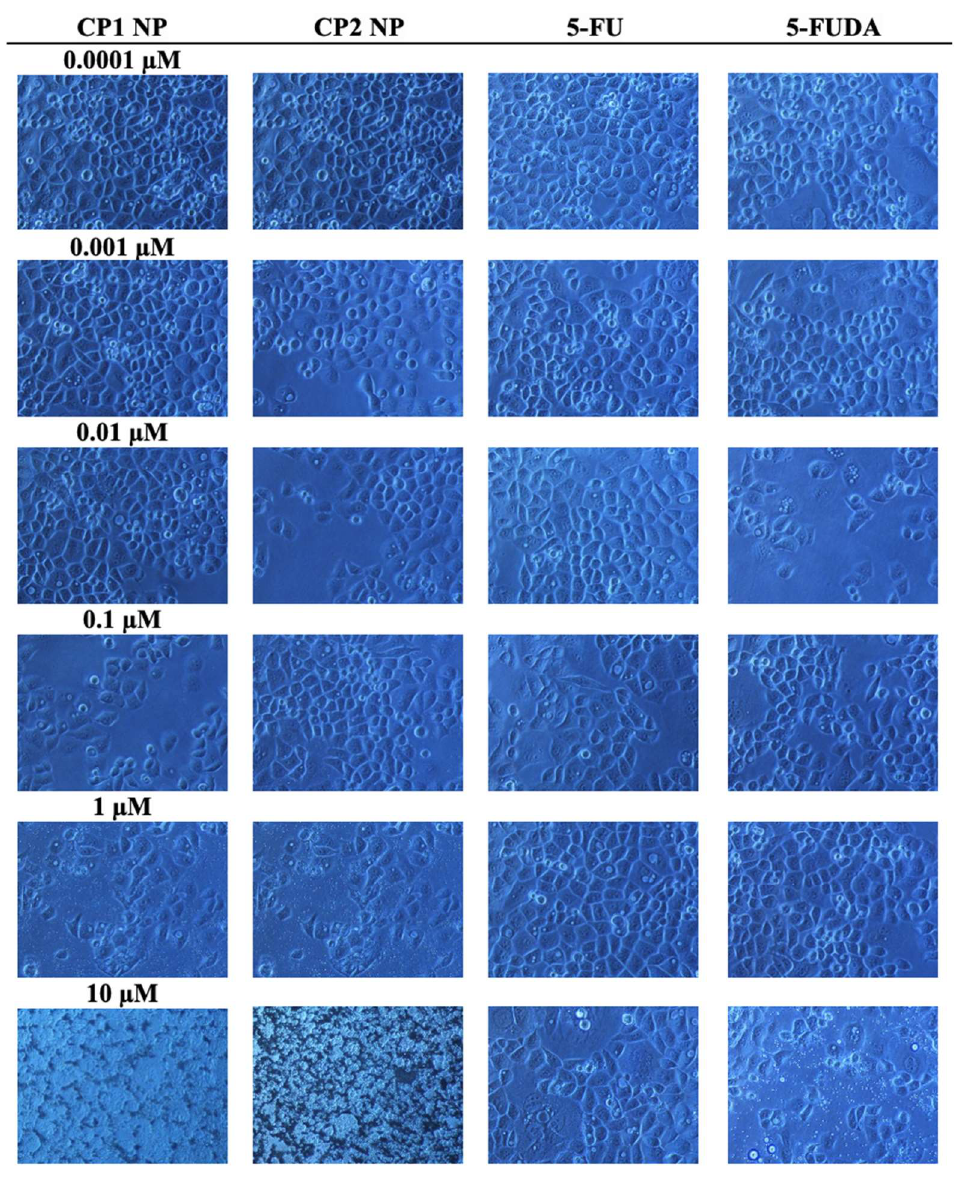
Figure 4. Microscopic images (magnification 20 × ) of PANC-1 cells after 24 h treatment with 5-FU , 5-FUDA , and CP1 and CP2 NPs in MTT assays at different concentrations.